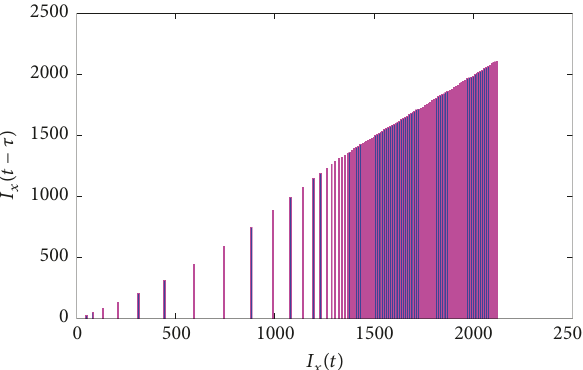
Figure 6: The relationship between 𝐼 𝑥 (𝑡) , 𝐼 𝑥 (𝑡−𝜏) with 𝜏 = 0.1 , 𝛼 = 0.95 using NSFDM.